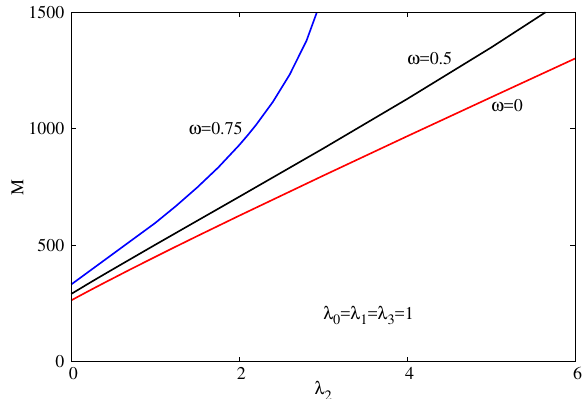
Figure 12 . The mass M is shown as a functions of the parameter (cid:21) 2 , for static and spinning Skyrmions, with di(cid:11)erent frequencies.